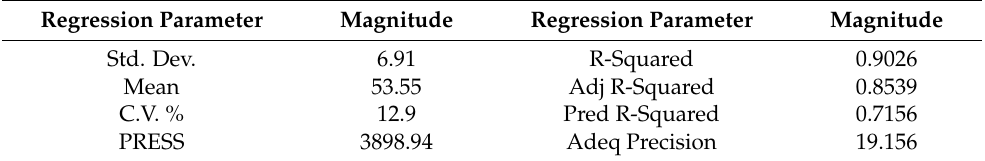
Table 8. Regression